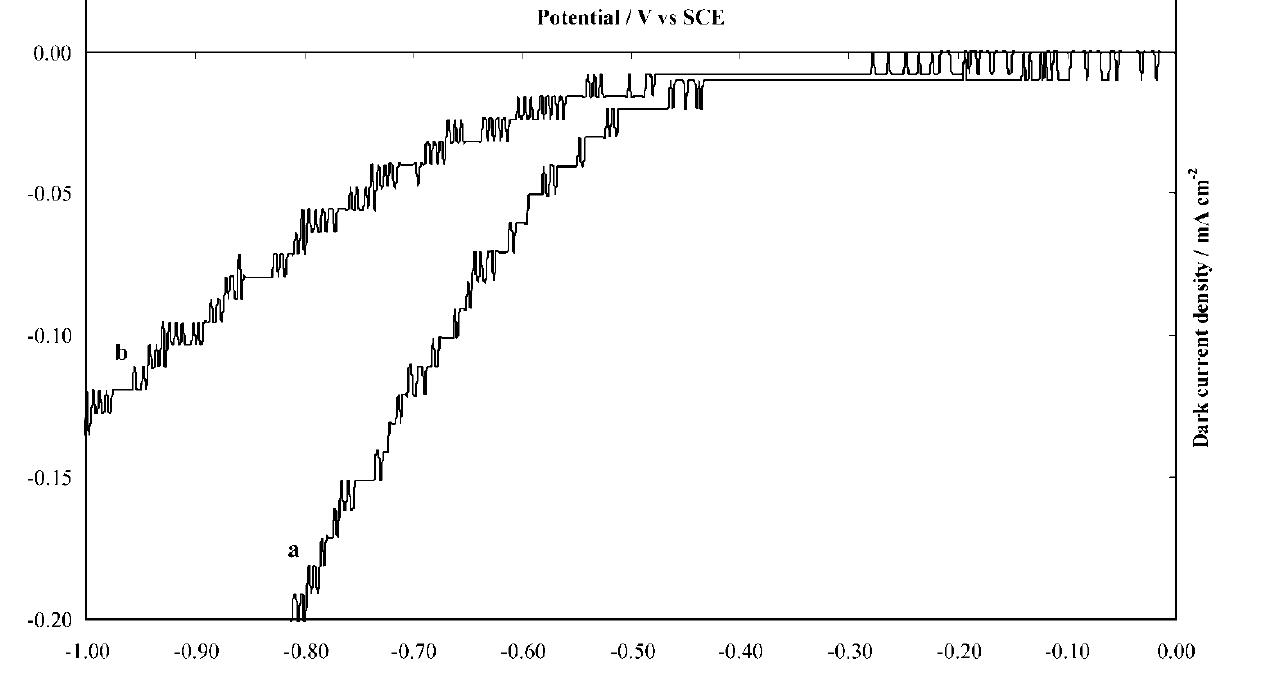
FIGURE 3 Dark J – V plots of (a) slowly cooled and (b) quenched n -Si samples from 400 (cid:1) C. All J – V measurements were conducted in water = LiClO 4 = K 4 [Fe(CN) 6 ] = K 3 [Fe(CN) 6 ] at 25 (cid:1)